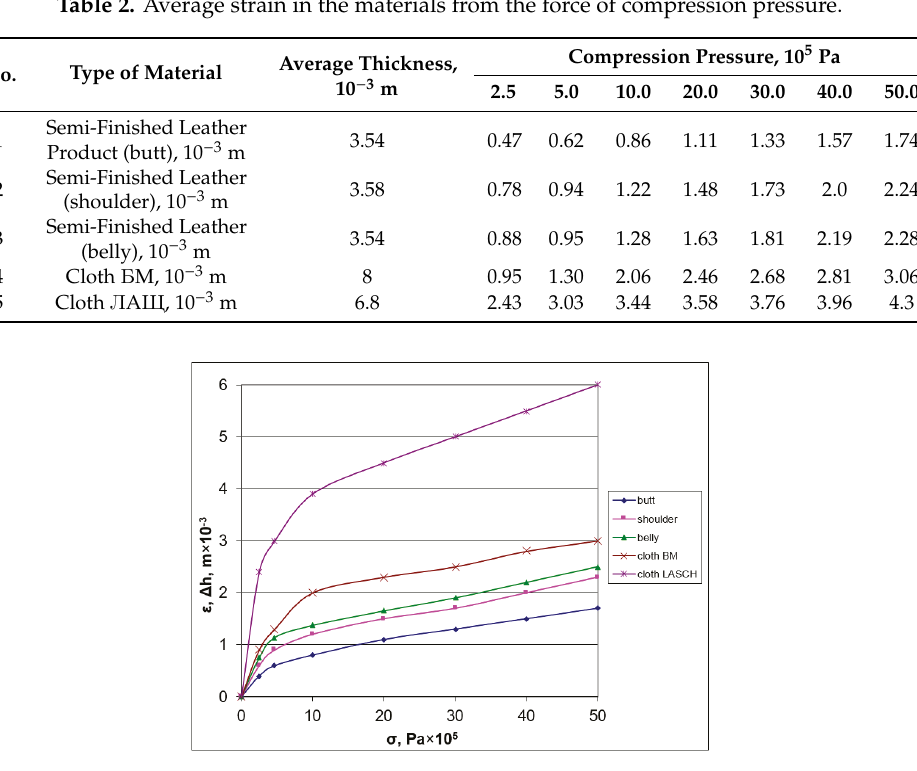
Figure 2. Strain dependence in the leather semi-finished product in topographic sections and moisture-removing materials on the compression pressure of the working roll.